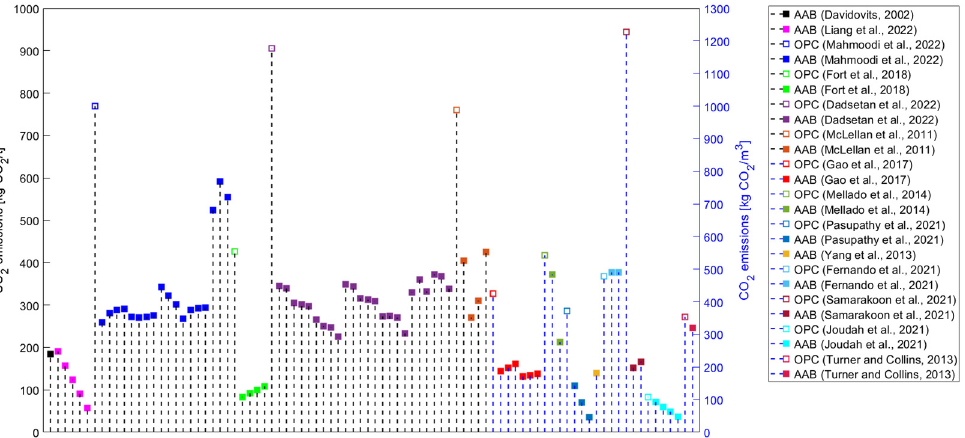
Figure 3. CO 2 emissions results for alkali-activated materials from the literature [4,5,10,46,48,59,60,67,101,102,127,130,144–146].